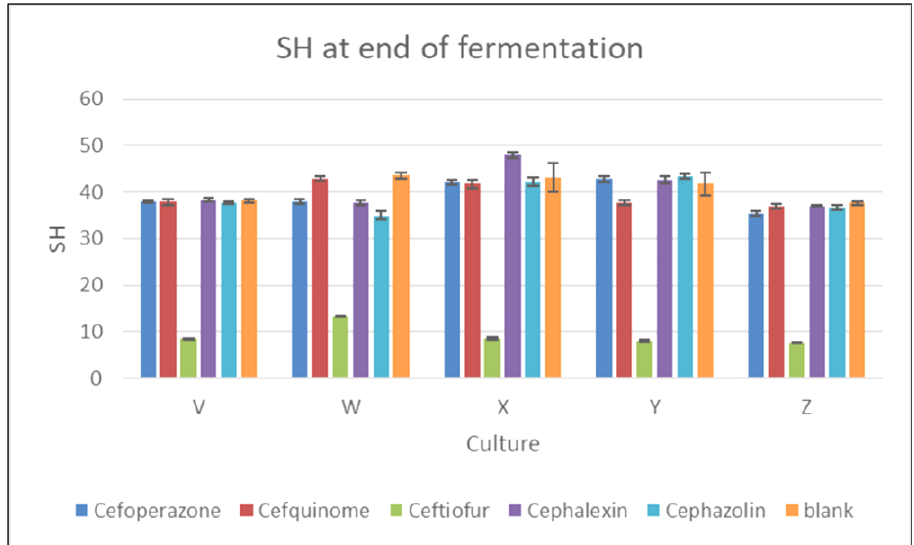
Figure 3. The effect of five cephalosporin antibiotics (cephalexin, cefoperazone, cefquinome, cefazolin, ceftiofur) on the activity of five yoghurt cultures (V, W, X, Y, and Z) in relation to titratable acidity (°SH) at the end of fermentation. Table 3. Concentration of organic acids at the end of fermentation in samples fortified with cephalosporins and in blank samples (mg 100 g − 1